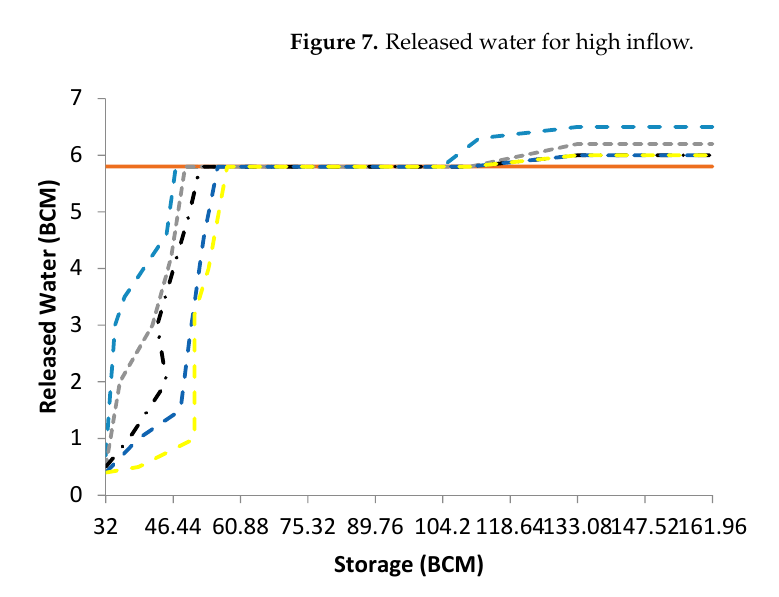
Figure 8. Released water for medium inflow.